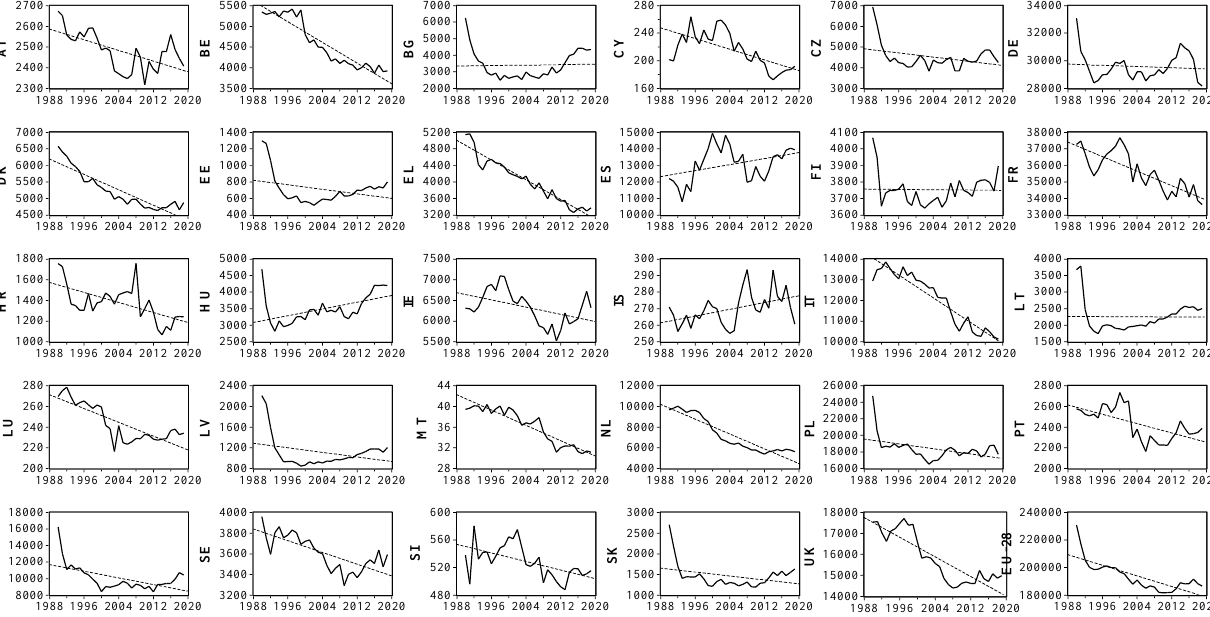
Similarly to CH 4 emissions, N 2 O emissions exhibited a negative trend from most of the EU-28 countries (Table 2, Figure 4). The total reduction in N 2 O emissions from all the EU-28 countries was − 916 thousand tons/year ( p < 0.05) (Table 2). However, some countries showed a significant positive trend of N 2 O emissions; for instance, LV (+7.79 thousand tons/year, p < 0.05), LT (+24.14 thousand tons/year, p < 0.05),